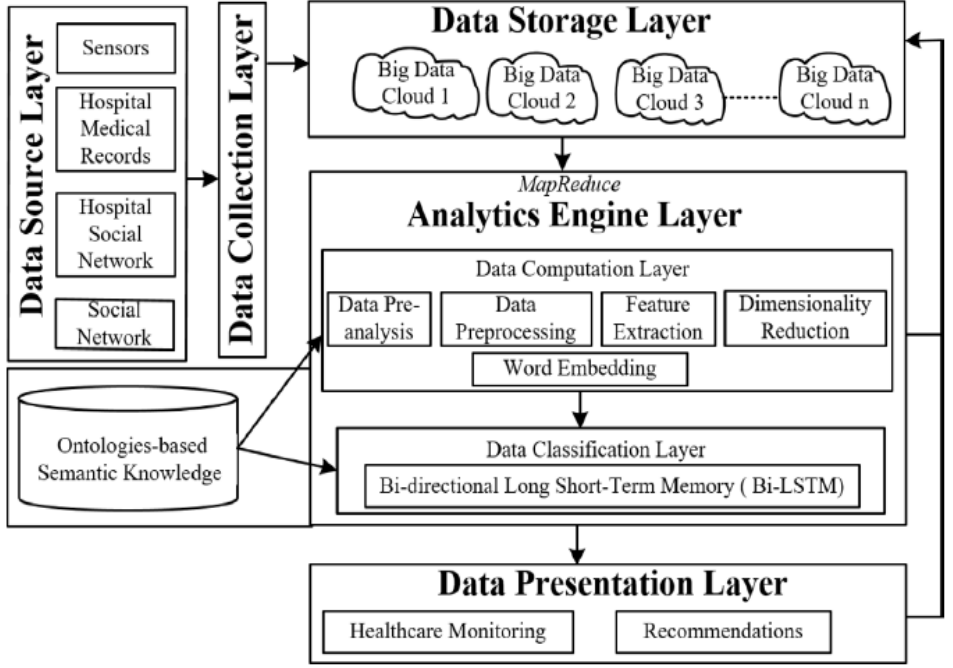
Figure 5. Architectural overview of the healthcare monitoring system (Ali et al., 2021 [52]).